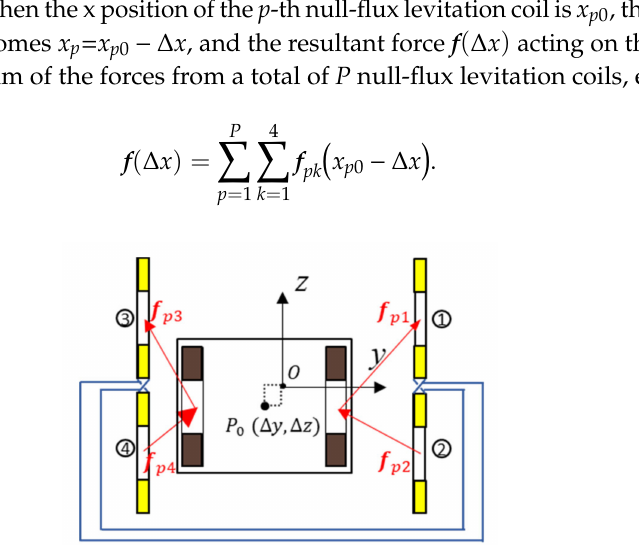
Figure 9. The null-flux force of the p-th null-flux levitation coil acting on the moving SCM with a